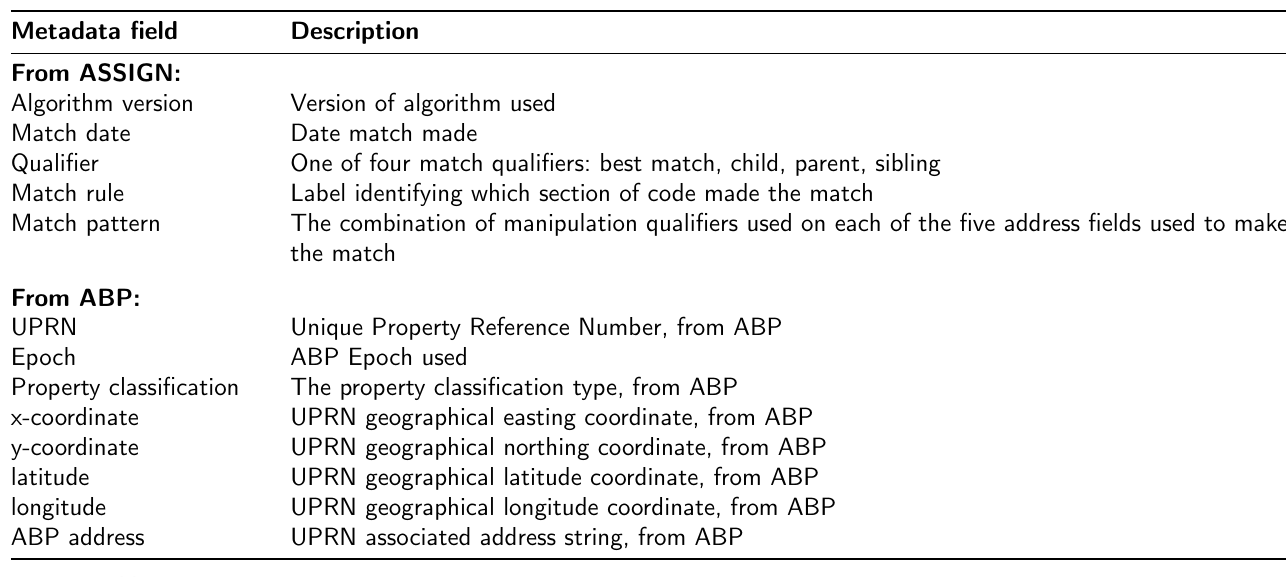
Table 2: Unique property reference number (UPRN) match